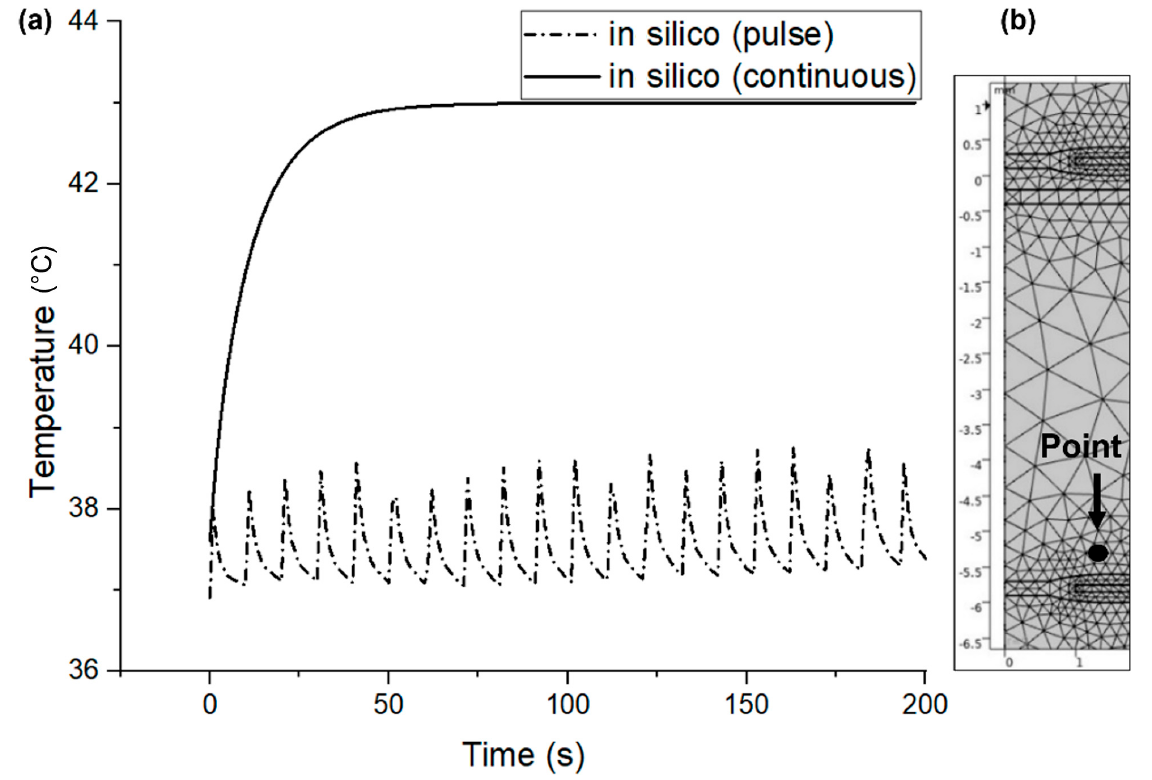
Figure 12. ( a ) Generated point graph from the simulated results above the implanted coil surface for 5 W LVAD, and ( b ) the position of the point.